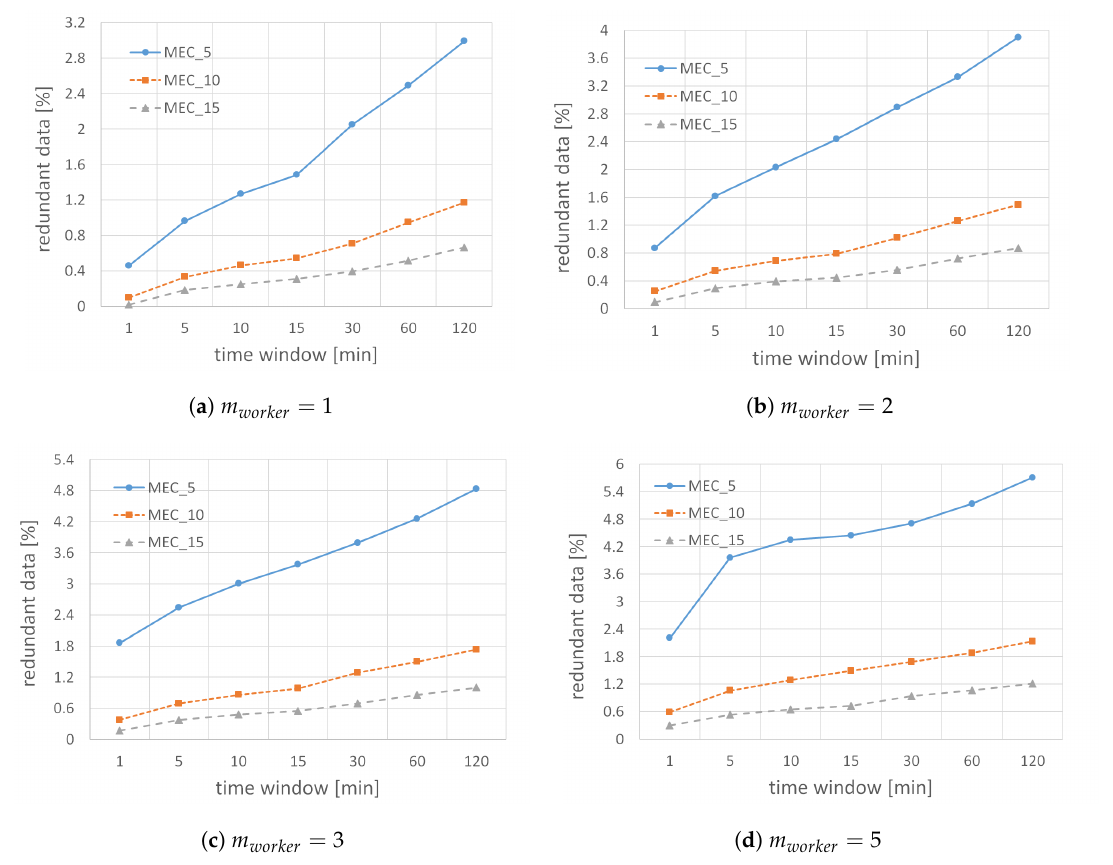
Figure 12. Percentage of redundant data received by ME hosts with respect to the parameter m worker